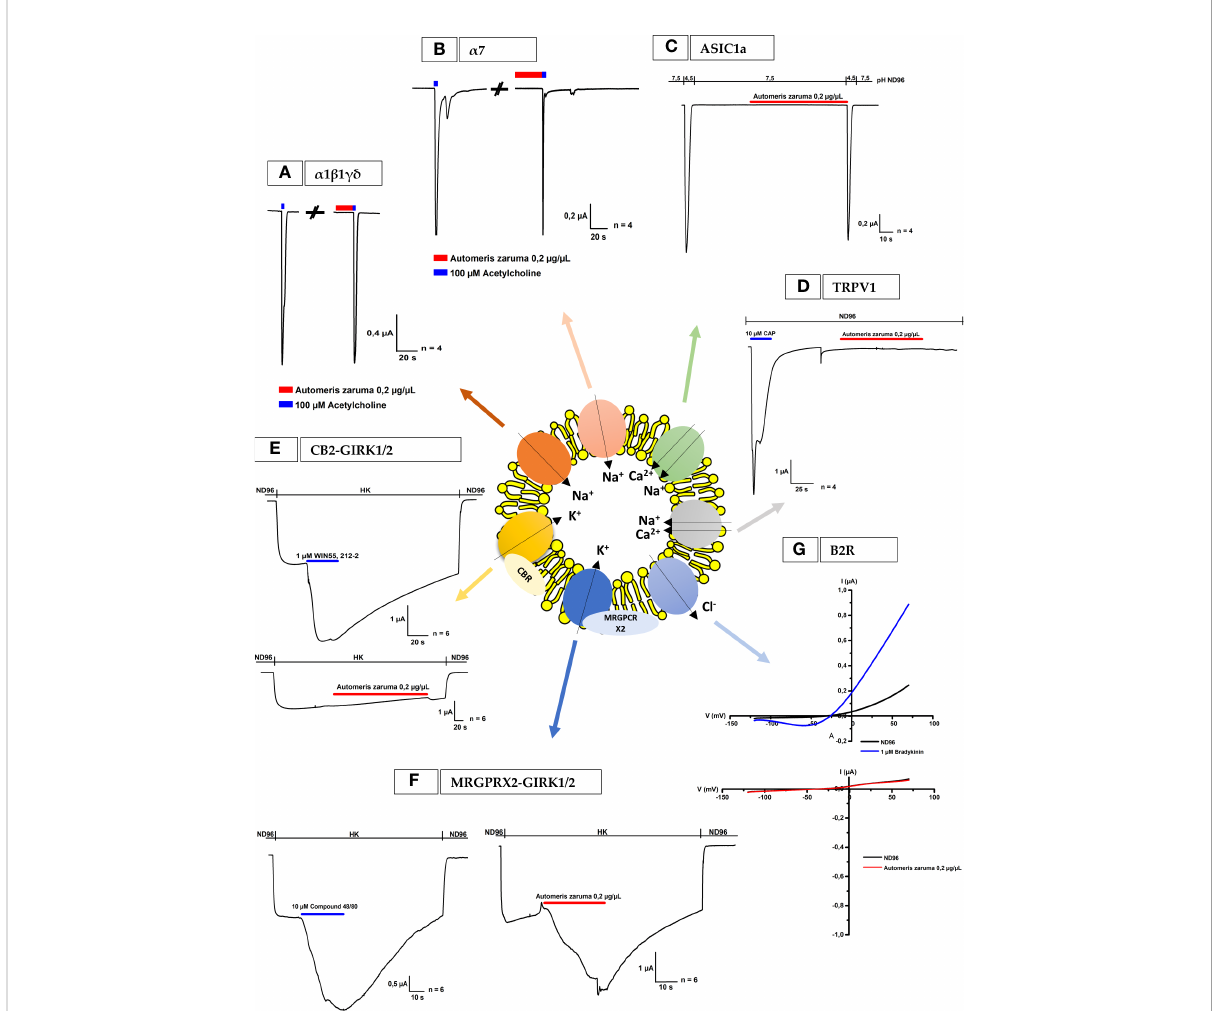
FIGURE 4 Electrophysiological activities of A. zaruma on nAChR, ASIC1a, TRPV1, B2R and oocytes co-expressing CB2 or MRGPRX2 and GIRK1 and GIRK2. (A, B) Electrophysiological pro fi le of muscle-type a 1 b 1 gd nAChR and neuronal-type of a 7 nAChR. The nAChRs were gated by 100 µM ACh (blue) at 1 mL/min. The fi rst and the second peak amplitude represent the absence and presence of 0.2 µg/µL of A. zaruma venom. (C) Whole-cell ASIC1a current traces in control pH 4.5 and in the presence of A. zaruma venom extract in pH 7.5 and pH 4.5. (D) Lack of effect of 0.2 µg/µL A. zaruma venom extract on TRPV1 channels. The fi rst peak amplitude represents the presence of the 10 µM Capsaicin agonist. (E) A representative current trace of CB2-GIRK1/2. Current enhancement is observed upon application of 1 m M WIN55,212-2 (blue) but no signi fi cant effect was visible in the presence of 0.2 µg/µL A. zaruma venom extract (red). (F) Validation trace experiments of MRGPRX2-GIRK1/2, currents were induced upon application of 10 m M compound 48/80 (blue, left) and in the presence of 0.2 µg/µL A. zaruma venom extract (red). (G) A representative trace of 1 µM bradykinin evoked a change of conductance (blue) and no signi fi cant trace was evoked by 0.2 µg/µL A. zaruma extract on B2R. All experiments were repeated at least three times (n ≥